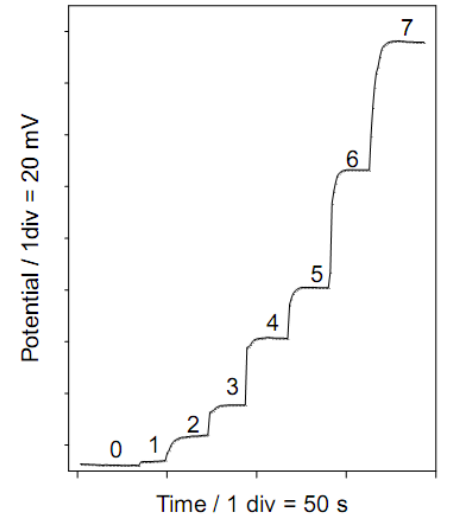
Figure 5. Dynamic response of electrode to different sulpiride concentrations.